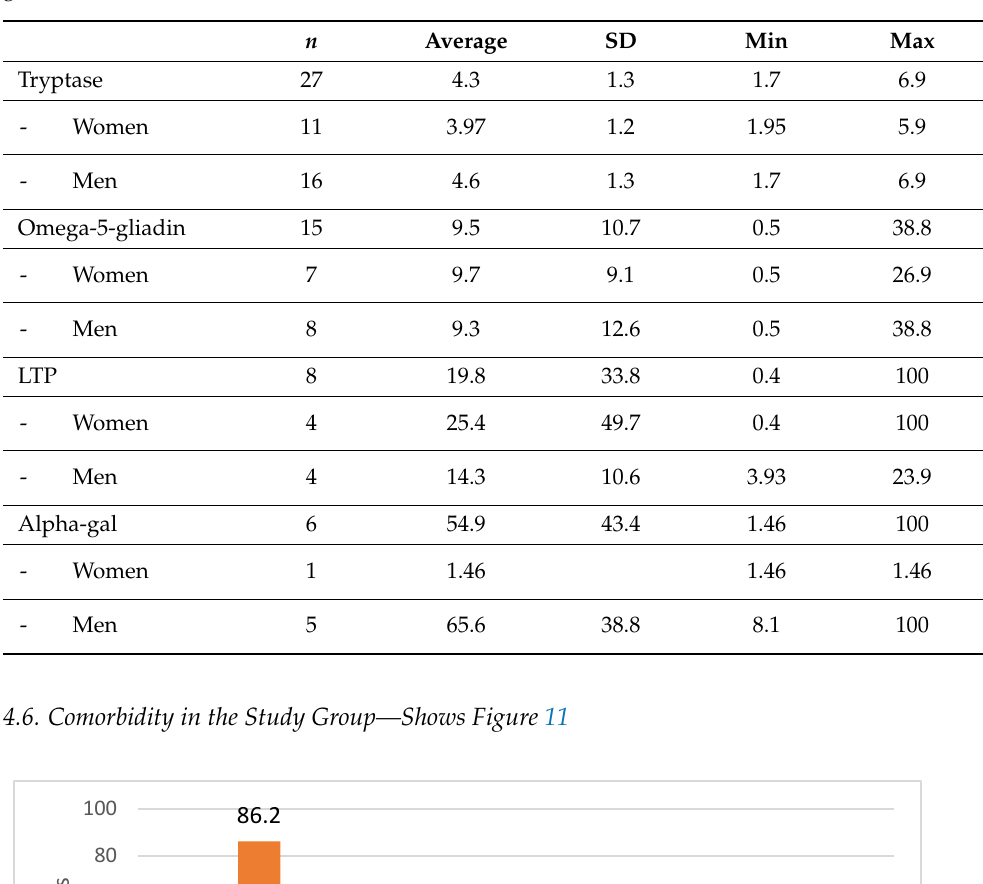
Table 2. The characteristics of sIgE values and tryptase in the study group ( n = 29) with division by gender.